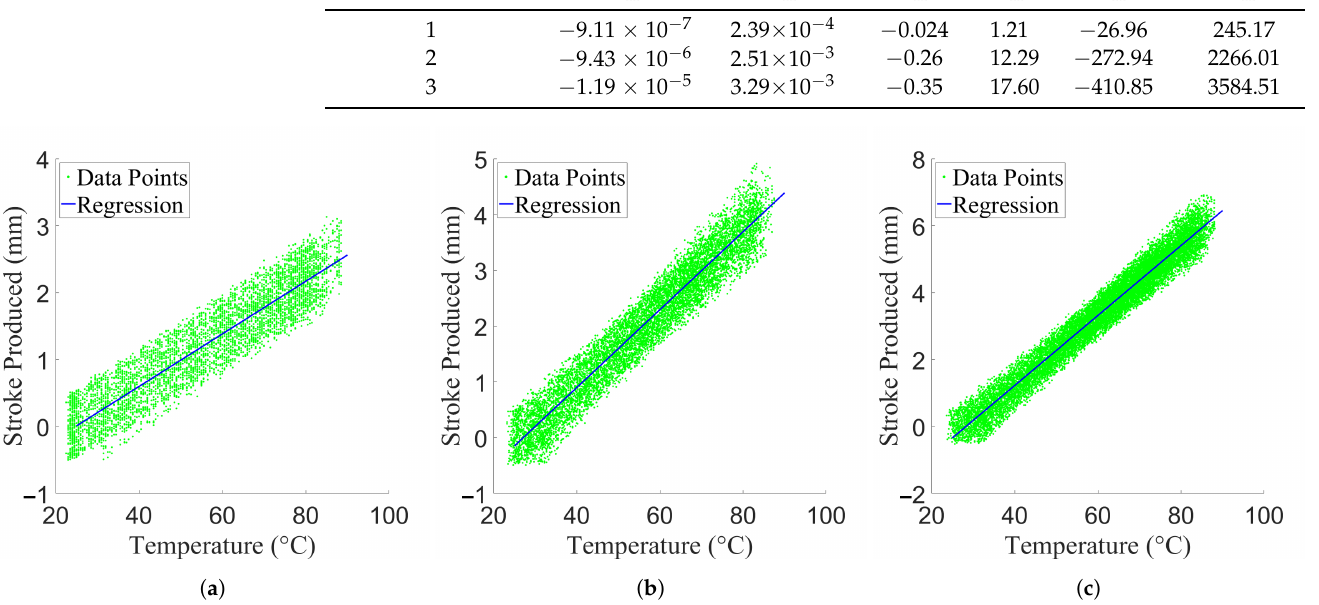
Figure 10. Regressed temperature–stroke relationships overlaid over experimental data, separated by activation level. ( a ) One activated pair. ( b ) Two activated pairs. ( c ) Three activated pairs.